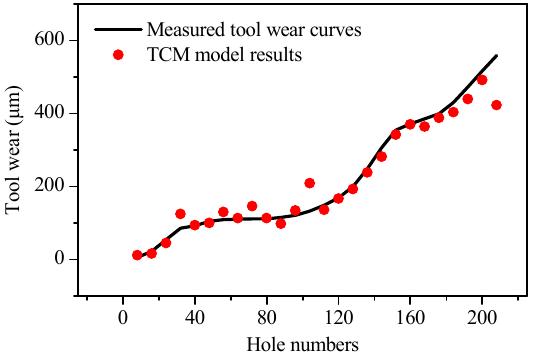
Figure 10. Tool condition monitoring results.